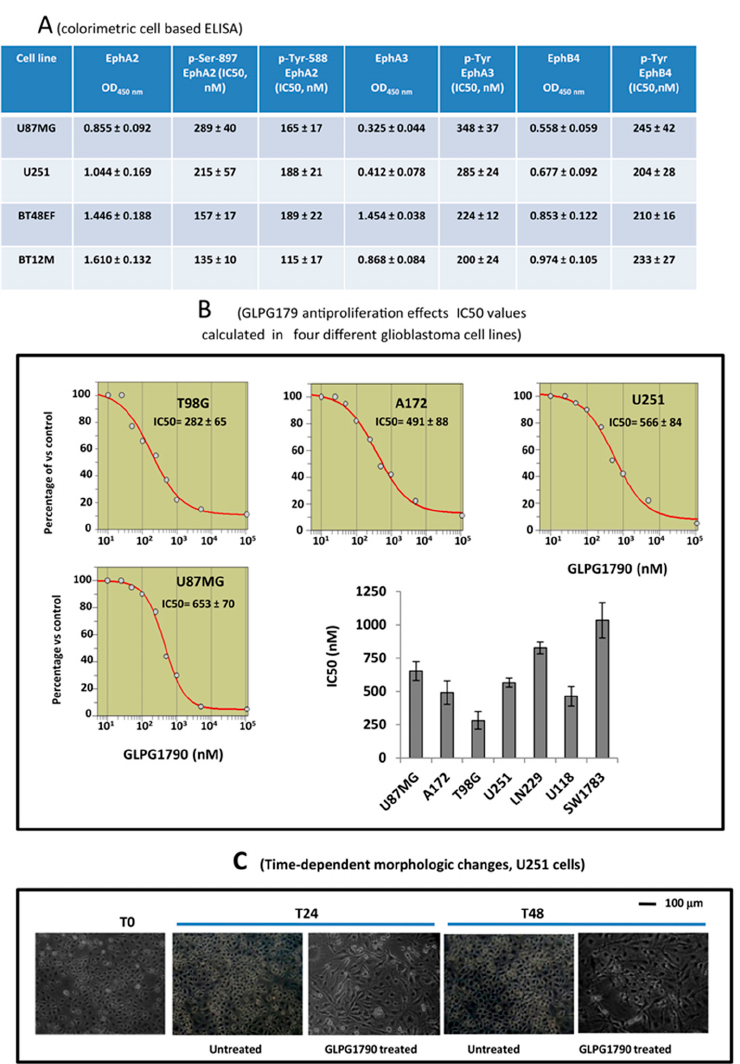
Figure 1. Biochemical and cellular effects of different doses of GLPG1790. ( A ) Colorimetric cell-based ELISA determinations for total and phosphorylated Tyr588 and Ser897 EphA2, total and phosphorylated Tyr779 EphA3 and total and phosphorylated Tyr987 EphB4 in GLPG1790-treated U87MG cells. Data show also the IC50 values calculated for the inhibition of phosphorylation for EphA2, EphA3 and EphB4 isoforms. ( B ) Growth curves and IC50 determination for GLPG1790-treated A172, U251, T98G and U87MG and GBM cell lines as well as in BT48EF and BT12M GICs. ( B ) antiproliferative effects and IC50 values calculated for GBM cell lines. ( C ) Morphology of GLPG1790-treated U251